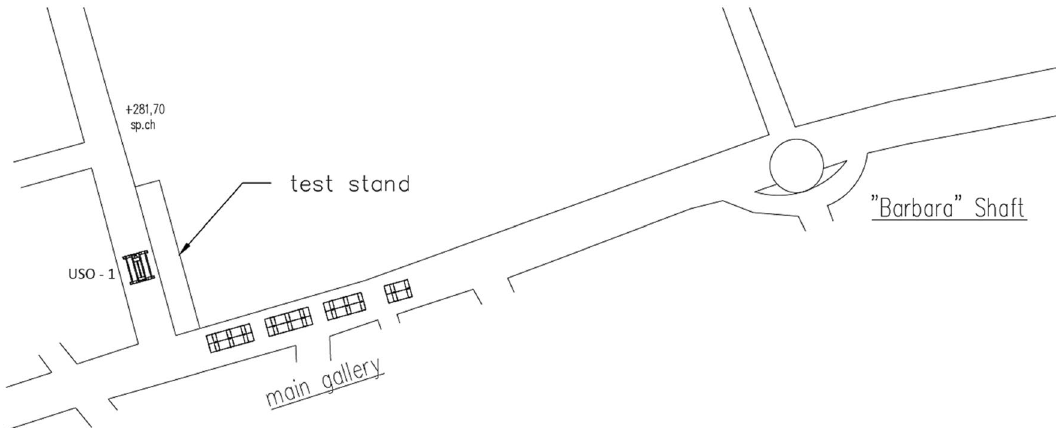
Figure 4. Map of the research area in the coalmine.